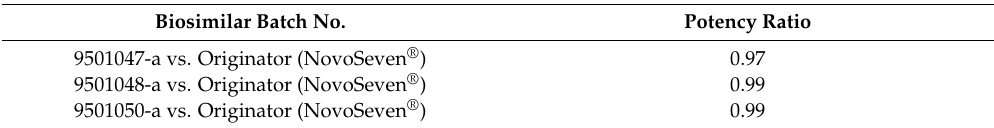
Table 2. AryoSeven™ biosimilar potency values measured by coagulation assay in comparison to the originator NovoSeven ® . Assays were performed in triplicates.